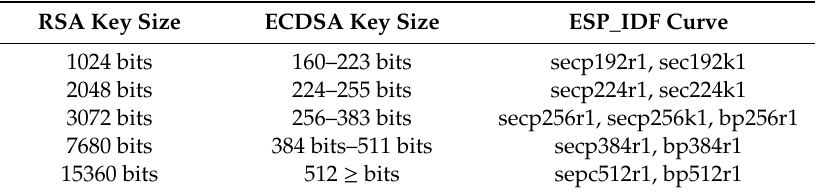
Table 2. Comparison of key size in Rivest, Shamir, and Adleman (RSA) and Elliptic Curve Digital Signature Algorithm